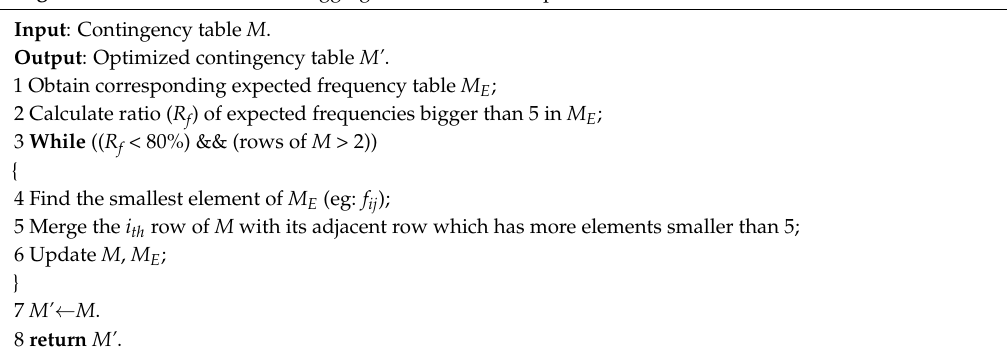
Algorithm 1. Recursive element aggregation for small sample size.